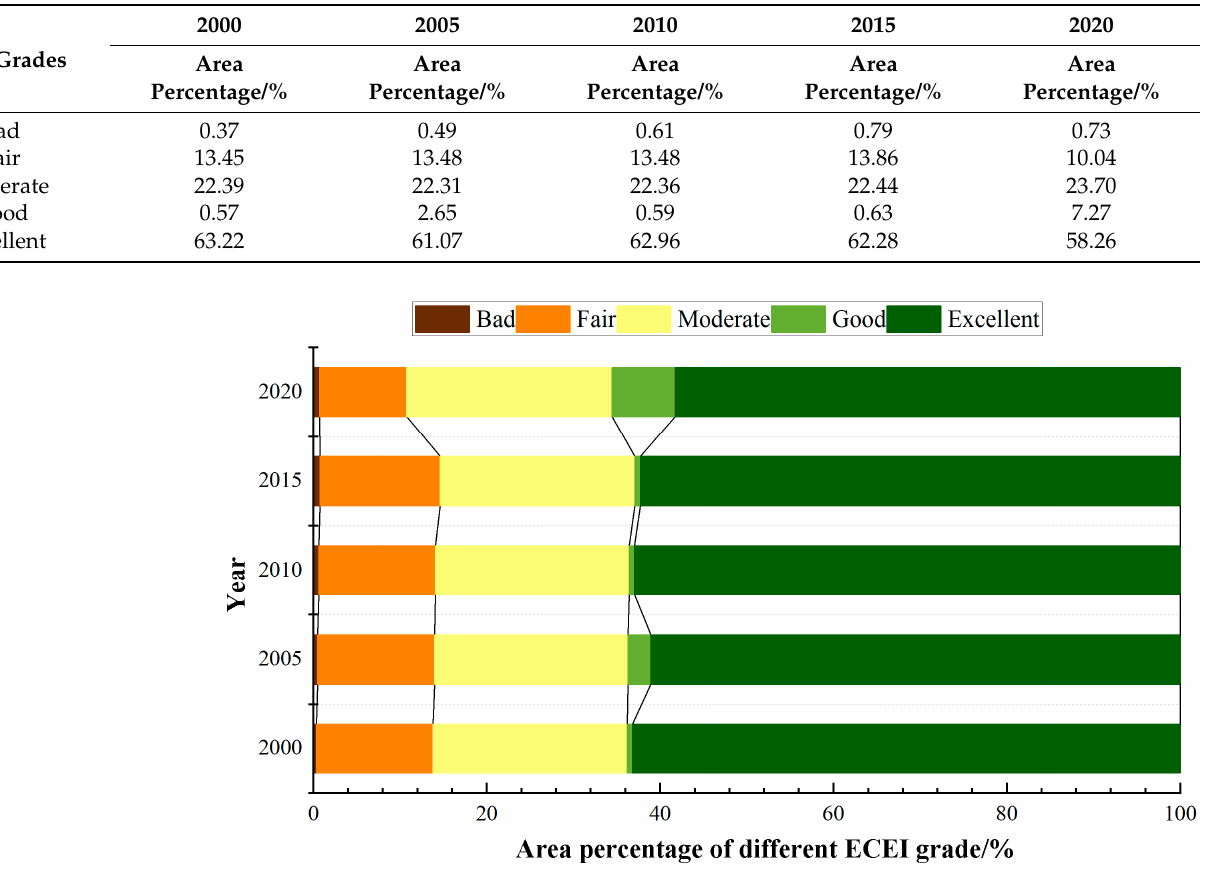
Figure 6. Average ECEI values of Zhaotong from 2000 to 2020.